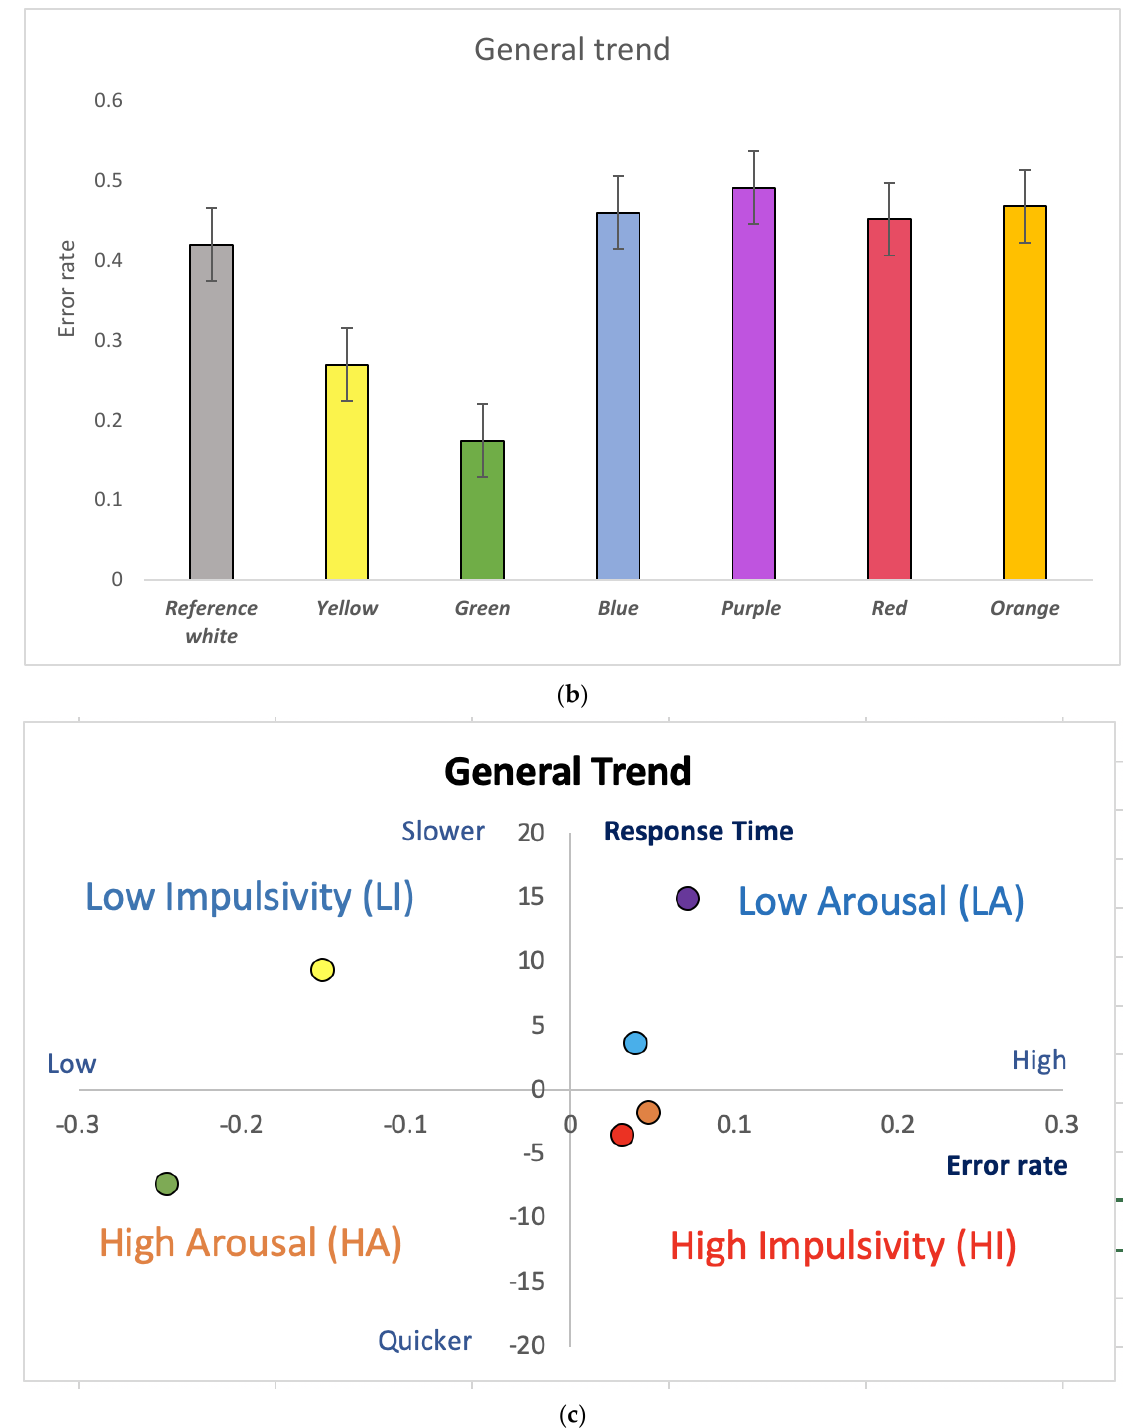
Figure 3. ( a ) General trend of response time by background colours; ( b ) General trend of error rate by background colours; ( c ) Colour impacts on general performance visualised in the Error-Speed space. The bars represent mean changes, while the error bars are the standard error of the mean across individual participants.